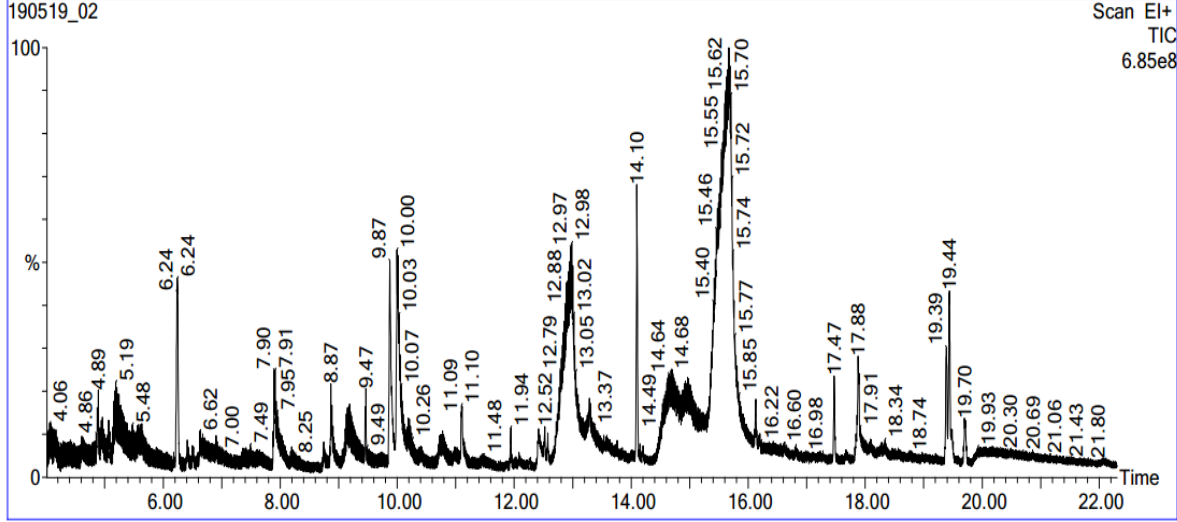
Figure 1 : GC-MS chromatogram of B.dioica